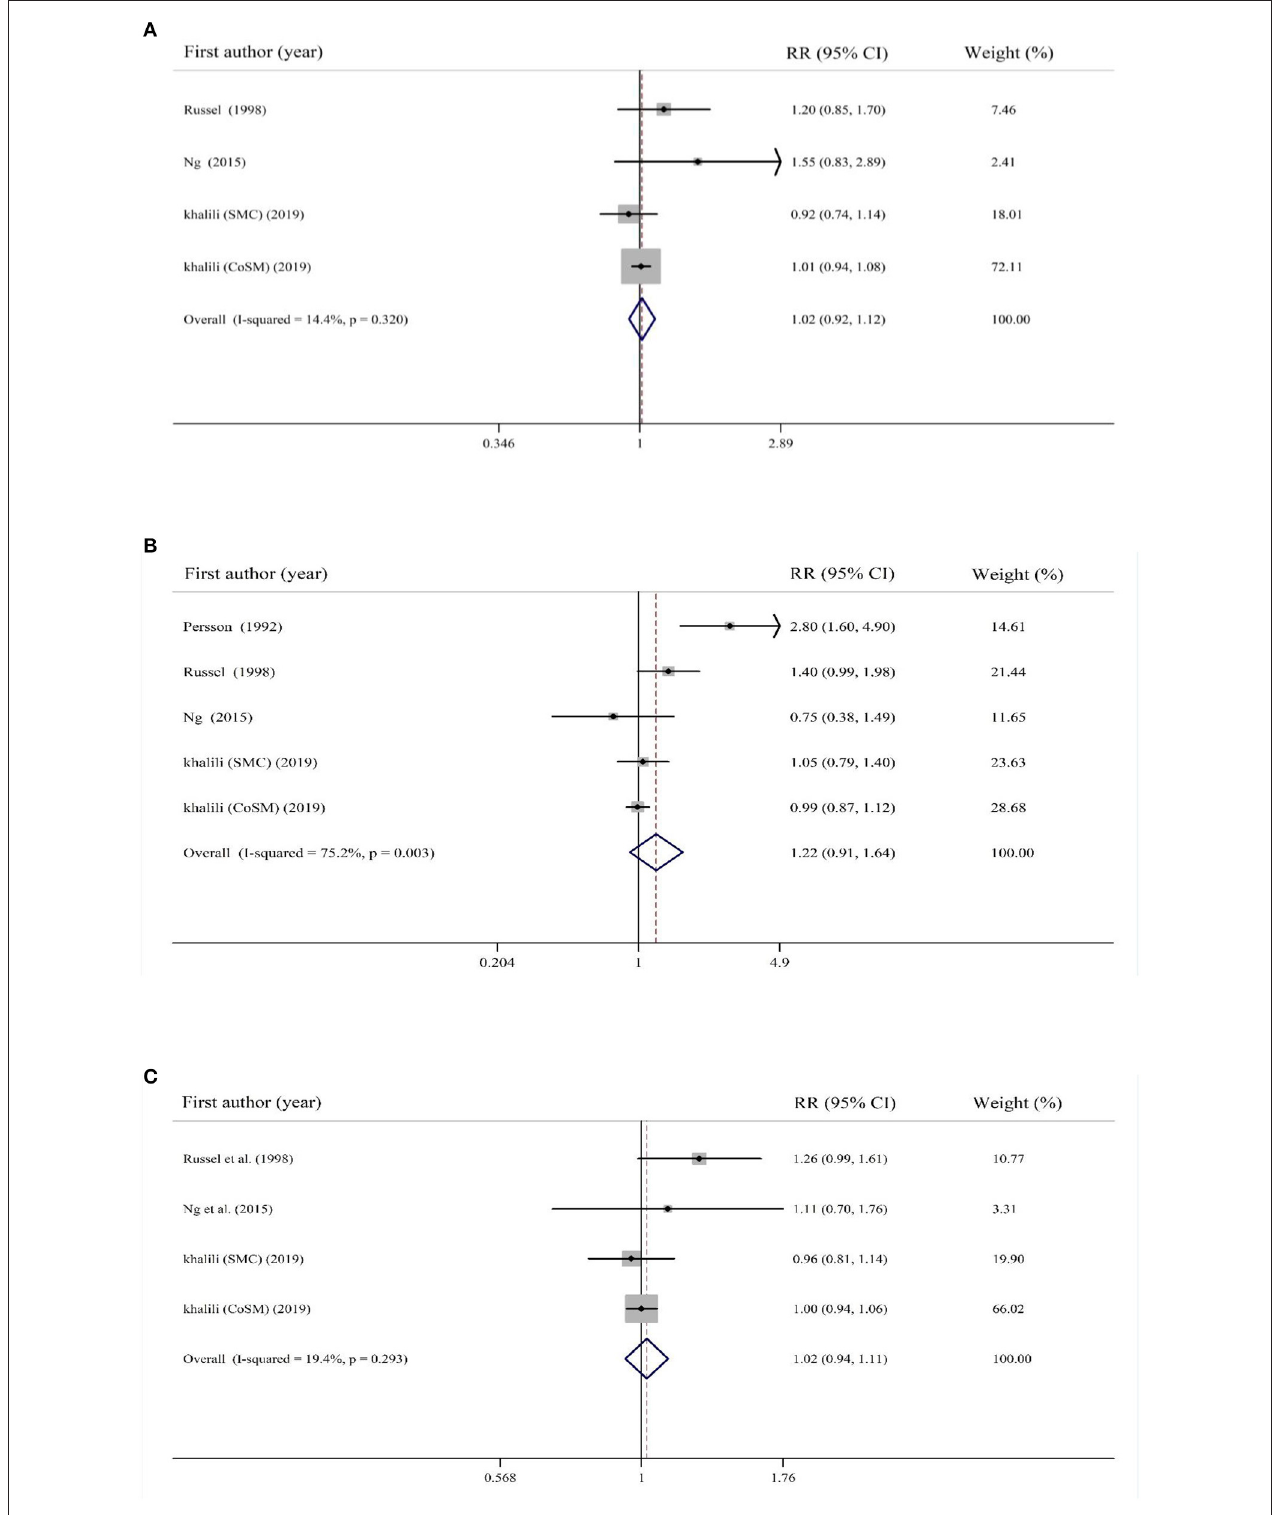
FIGURE 4 | Forest plot for the association of sugar-sweetened beverages consumption with risk of (A) UC, (B) CD, and (C) total IBD. Diamonds represent pooled estimates from random-effects analysis. Horizontal lines represent 95% CIs.